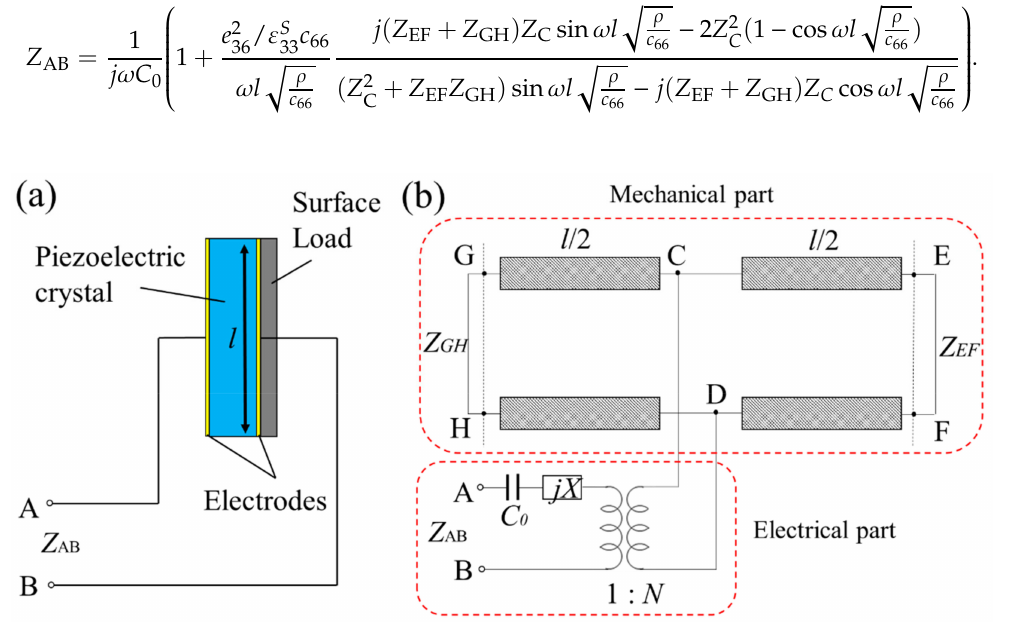
Figure 1. ( a ) A schematic of surface load sensing model; ( b ) an equivalent circuit model of the piezoelectric crystal with the acoustic loads where X is the reactance of the equivalent circuit and N is the turs ratio of a